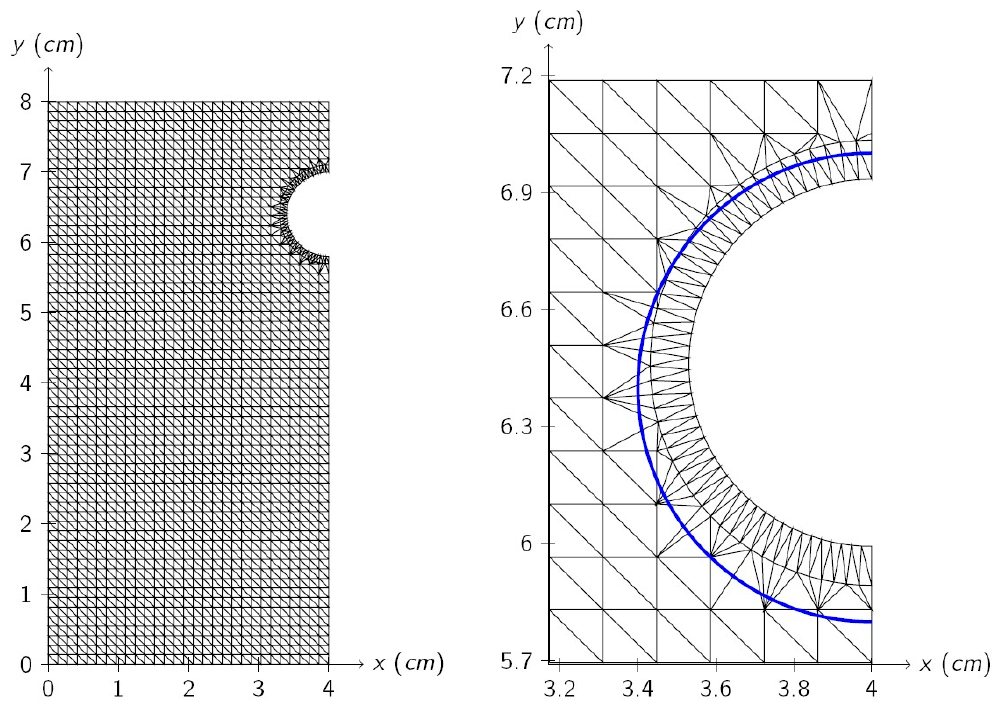
Figure 2. Initial mesh ( left ) and a detail of the mesh after one year of corrosion ( right ). The blue line shows the initial rebar shape.